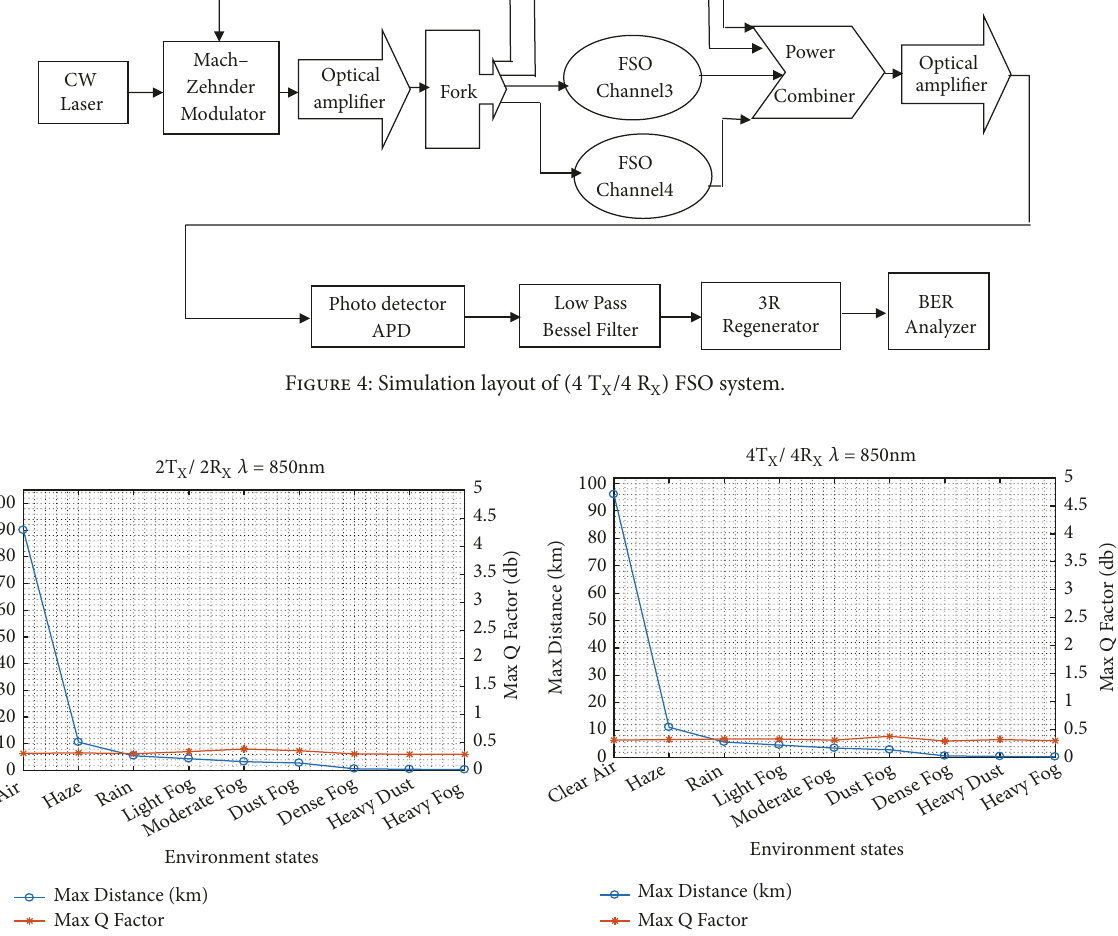
It can reach a distance of 115 km for the 2T X /2R X with clear air, while at heavy fog the maximum range is about 0.375